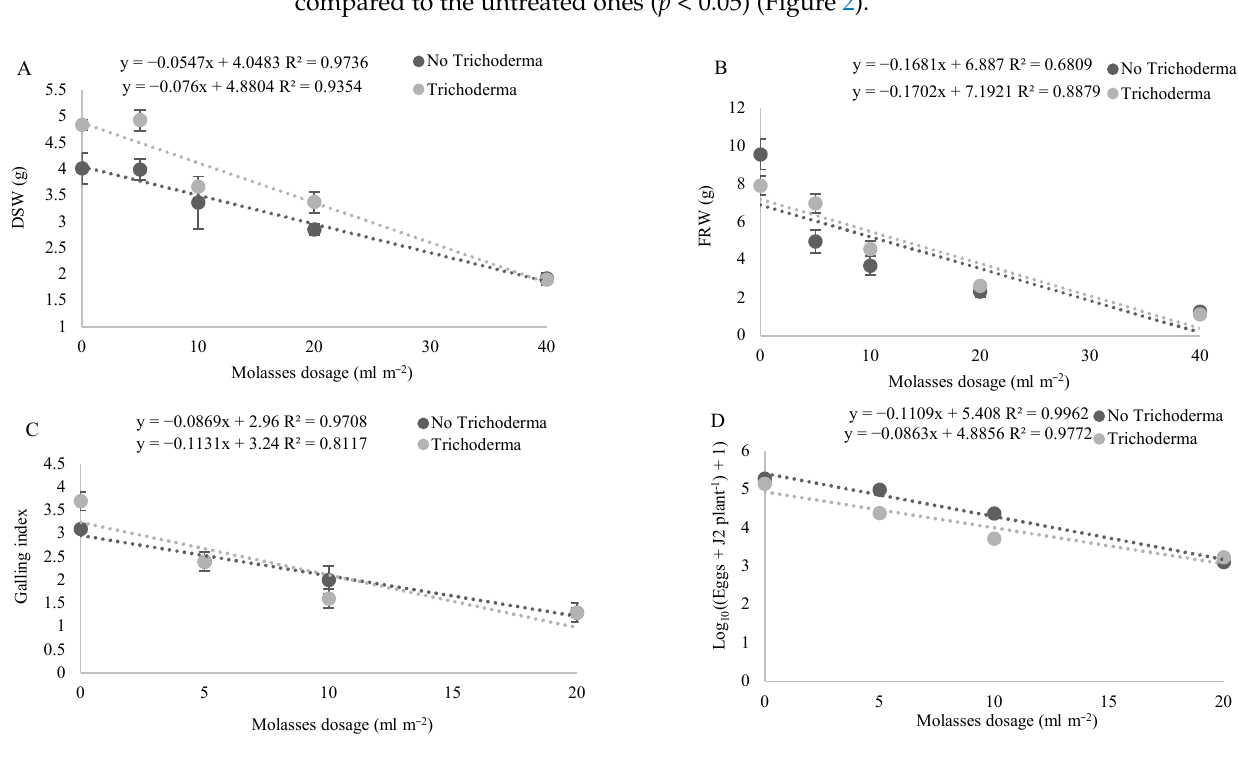
15.5 ± 1.0 Data are presented as mean ± standard error of 5 repetitions. Data of each parameter in the same column followed by * indicated differences between treatments according to the Wilcoxon test ( p < 0.05). 3.2. Effect of Molasses Alone or Combined with T34 Biocontrol on Meloidogyne spp. Reproduction and Soil Microbial Activity. During the 6 weeks of the pot experiment, the daily minimum, maximum, and aver- age soil temperatures were 21.4, 28.8, and 25.5 °C, respectively. Increasing molasses dos- age significantly reduced tomato plant biomass, regardless of the T34 Biocontrol applica- tion, being dramatically reduced at 40 mL m −2 , at which plants showed acute symptoms of phytotoxicity. Therefore, this molasses dosage was excluded from the regression anal- ysis to determine its influence on both disease severity and nematode reproduction. The tomato dry shoot and fresh root weight, disease severity, and nematode reproduction were inversely related to the increasing molasses dosage, irrespective of T34 Biocontrol application (Figure 1). The tomato dry shoot weight was significantly higher when T34 Biocontrol was combined with the molasses application (Intercept p = 0.0009; Slope p =